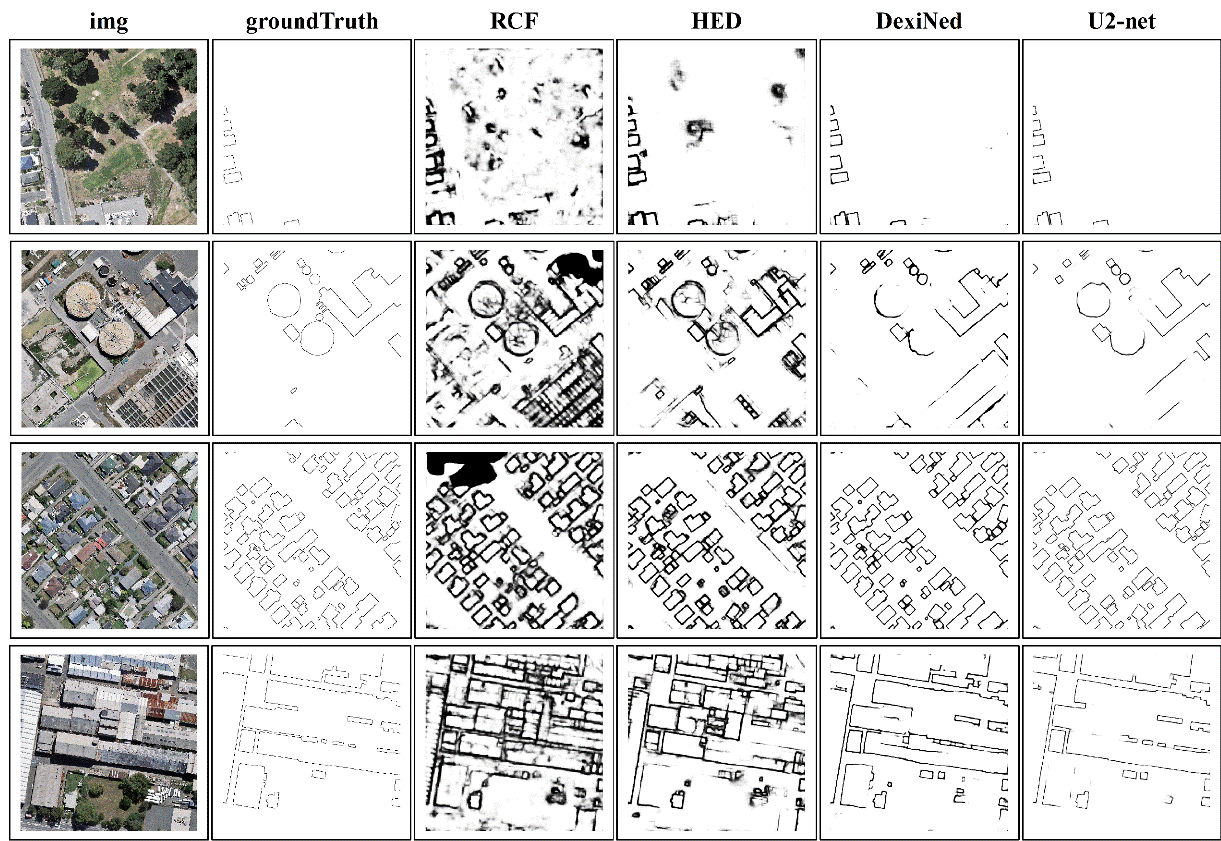
Figure 7. Visual comparison of different edge detection models on WHU dataset.